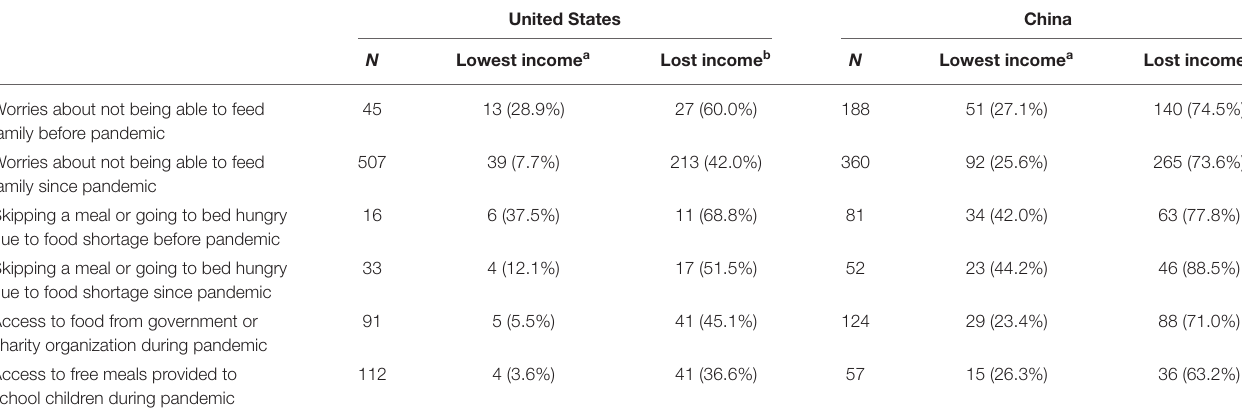
TABLE 1 | Household food insecurity situation worsened during the COVID-19 pandemic.